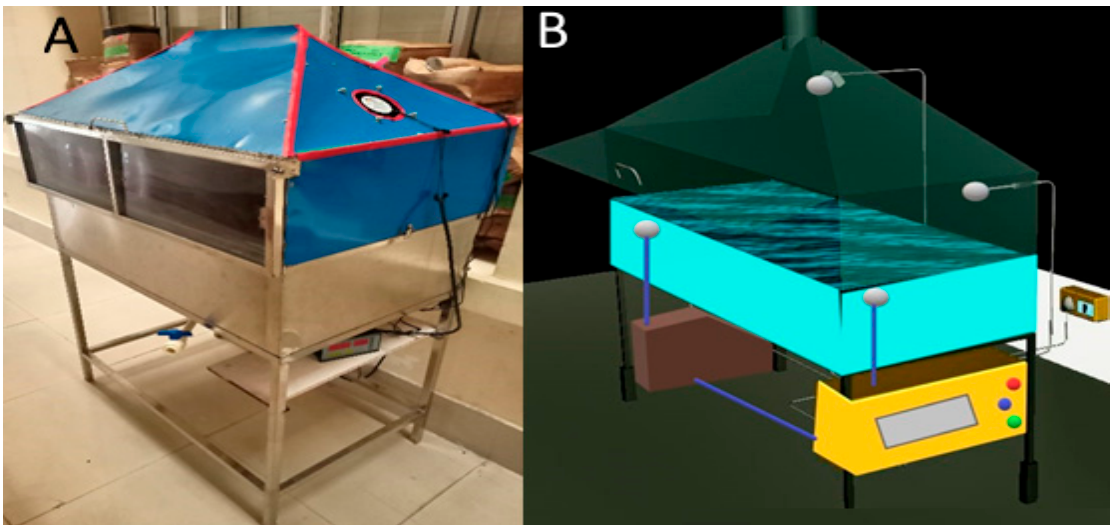
Figure 1. Refractance window drying (RWD) setup ( A ) and design ( B ).